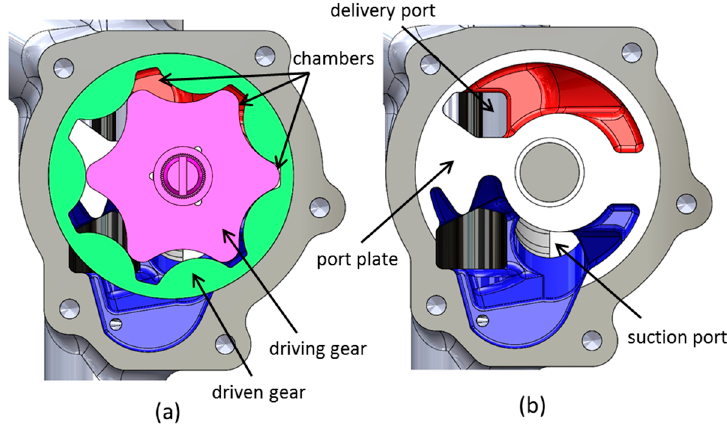
Figure 1. ( a ) Example of a lubricating gerotor pump; ( b ) detail of the port plate.